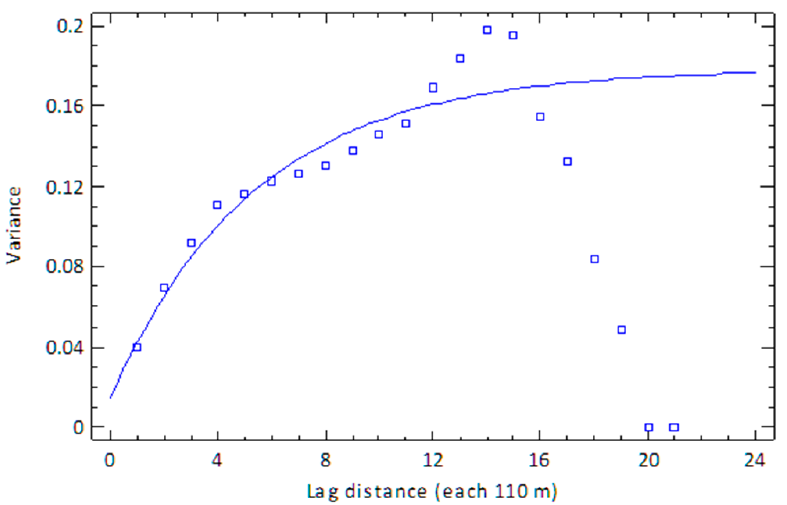
Figure 11. The fitted exponential model for MU site.